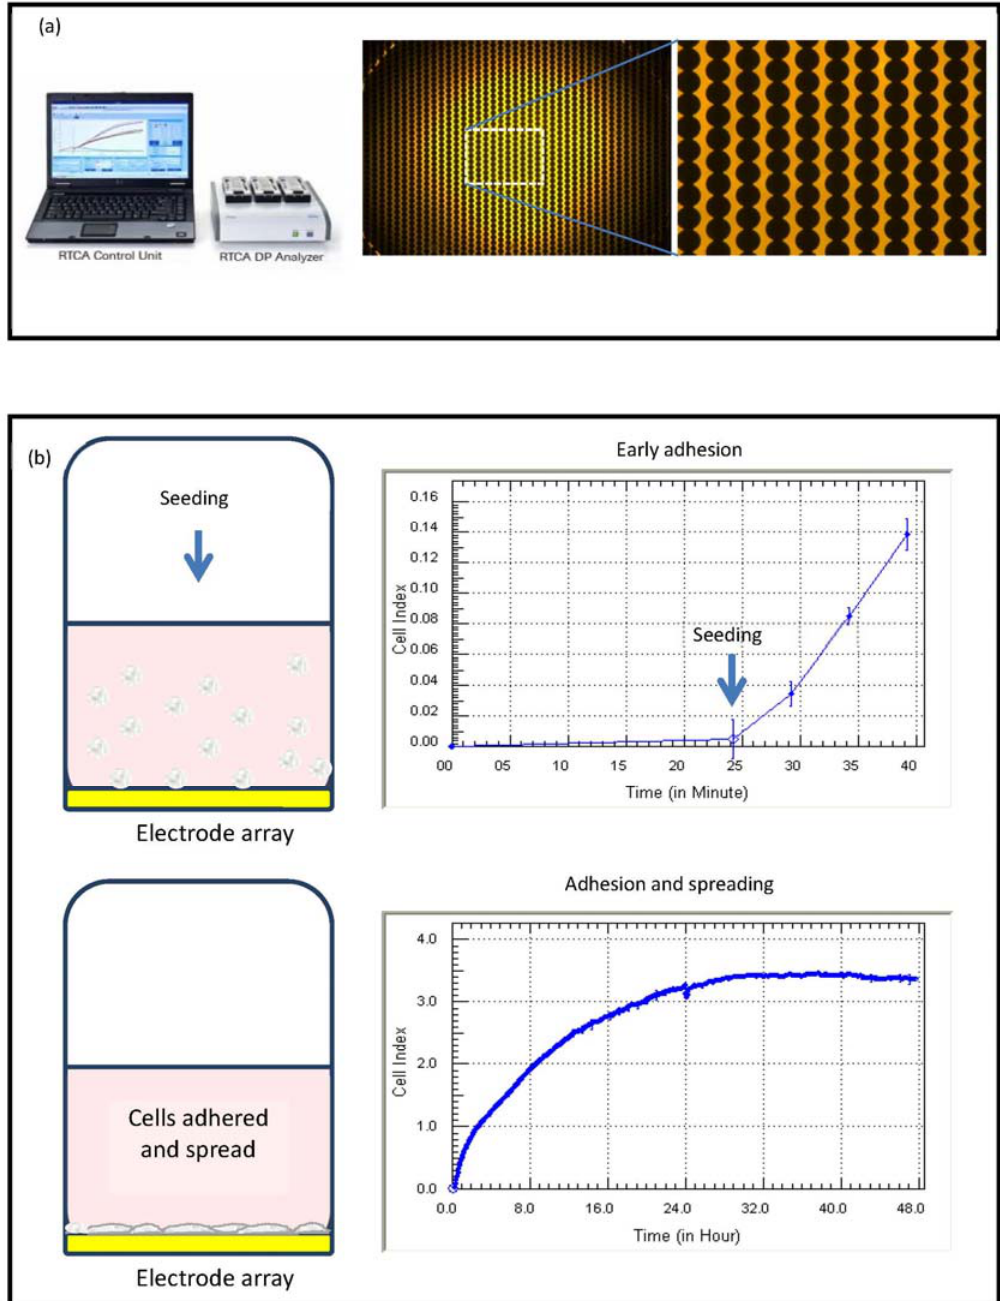
Figure 1. xCELLigence technology; impedance recording and cell adhesion. Summary of xCELLigence system technology and impedance, which shows: ( a ) the high density gold array on the E-plates; and ( b ) the initial phases of seeding and adhesion, which is recorded by the biosensor and represented as the Cell Index